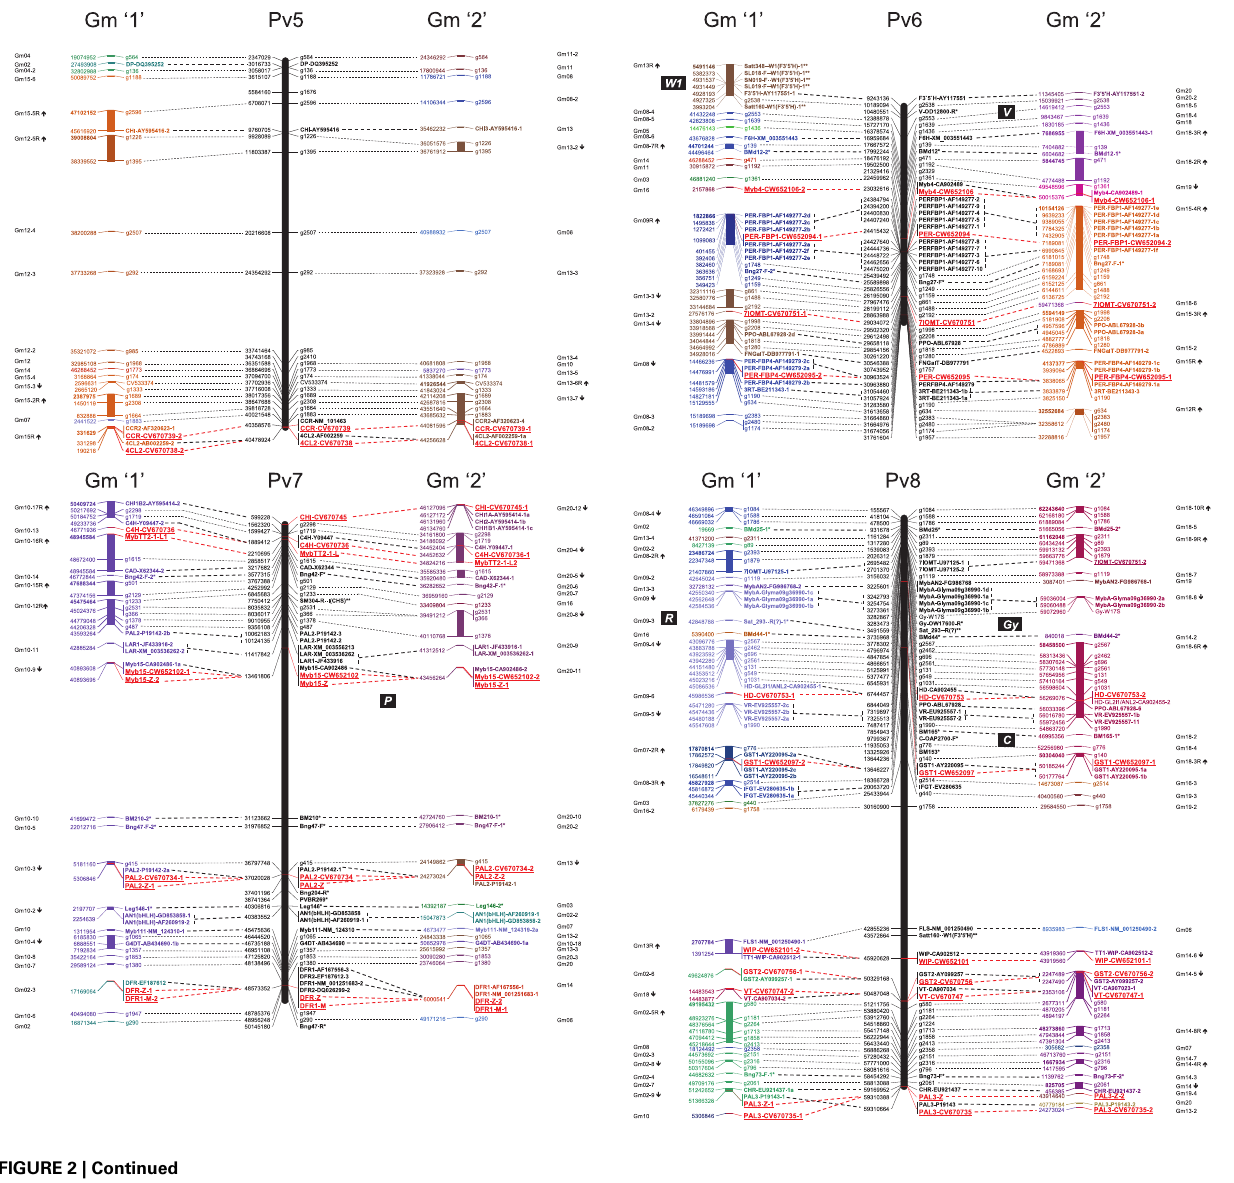
Pv3. Blocks of soybean chromosomes Gm02 (16 sequence features) and Gm05 (eight features)/Gm17 (21 features) and Gm02/Gm16 (six features) were syntenic to common bean chro- mosome Pv3 (McClean et al., 2010; Galeano et al., 2011). In addition, one to 11 sequences were shared between Pv3 and many (11) soybean chromosomes ( Figure 2 ). Eleven phenylpropanoid pathway genes were identified on chromosome Pv3, including five cloned in this study ( IFS -CV670762, 4CL1 -CV670737, F3H - CW652103, IFR -CV670750, and 3RT -CV670748). Two copies of the 4CL1 gene were found 13,788 bp apart on the common bean chromosome Pv3 ( 4CL1-2 at the start position 34,628,464 nt and 4CL1-1 at the start position 34,642,252 nt, respectively). Soybean seed coat color gene Wp , (purple flower and hypocotyl